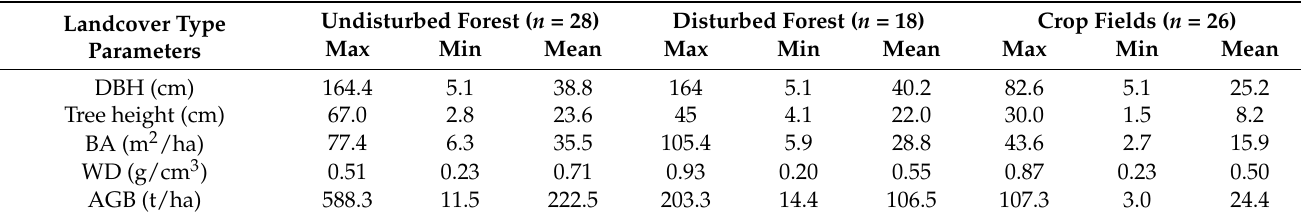
Table 2. Descriptive statistics of forest inventory plots.